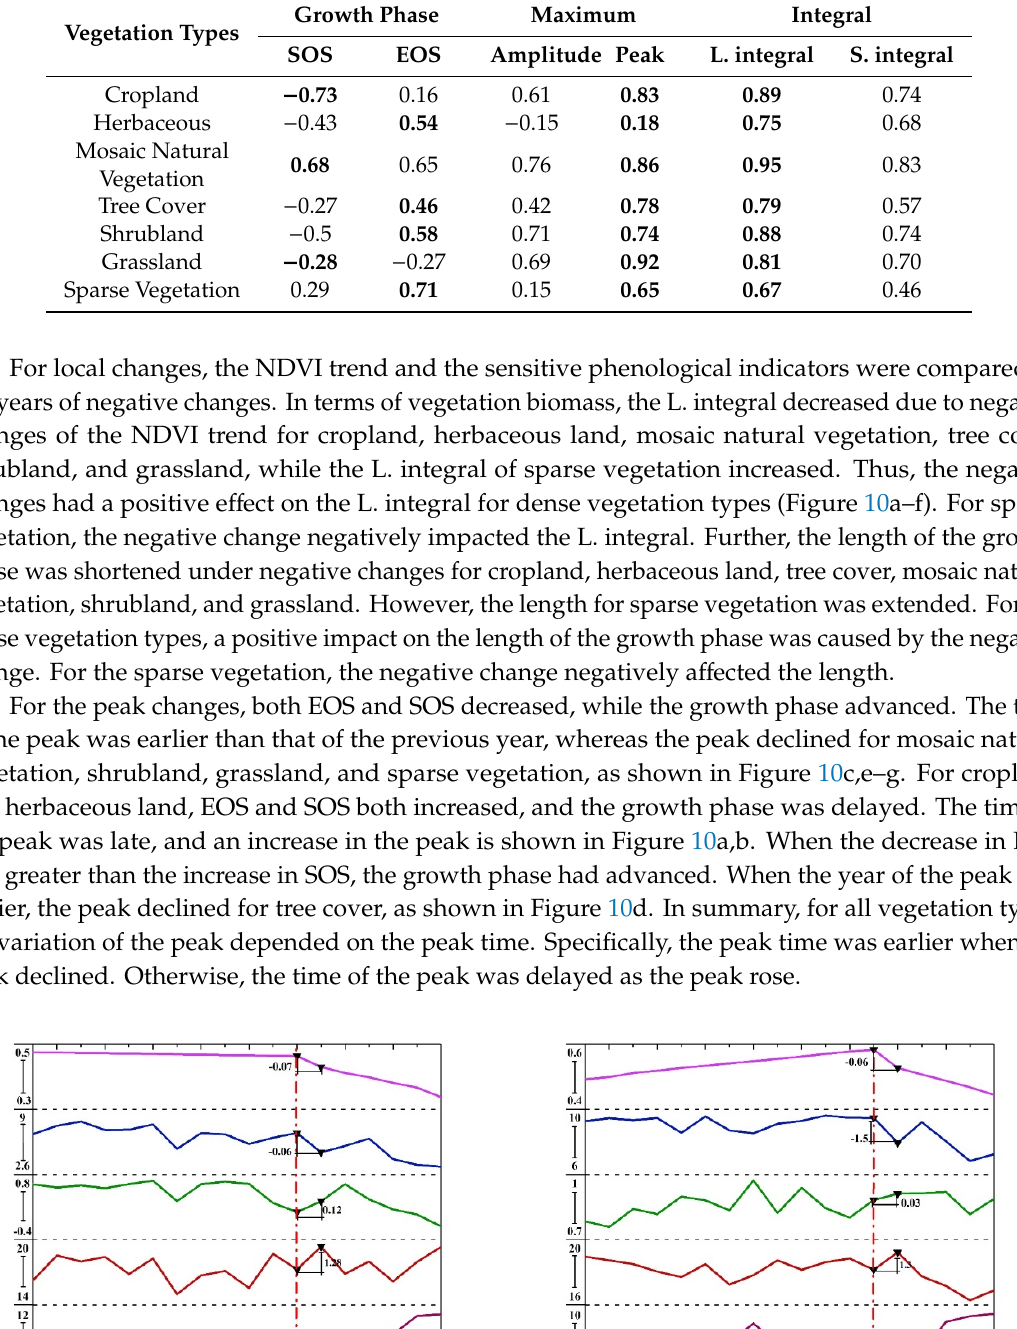
Table 3. The correlation coe ffi cients of phenological indicators and the NDVI trend for vegetation types. Vegetation Types